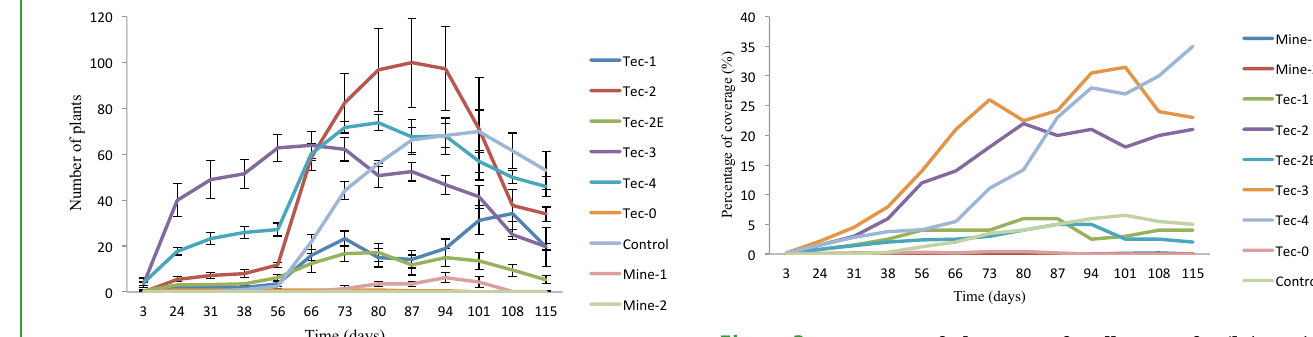
Figure 3. Percentage of plant cover for all types of soil through- out the experiment. Table 2. F and P values of a One-way ANOVA testing the e ff ect of treatment on the biomass of the four species grown individually in the Garden soil, Mine + Garden soil and Mine + CaCO 3